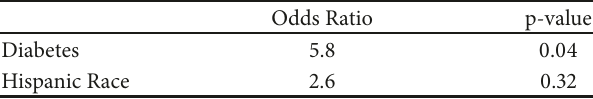
Table 3: Predictors of stroke in EoSC